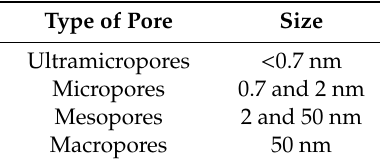
Table 3. Types of pore and their size.